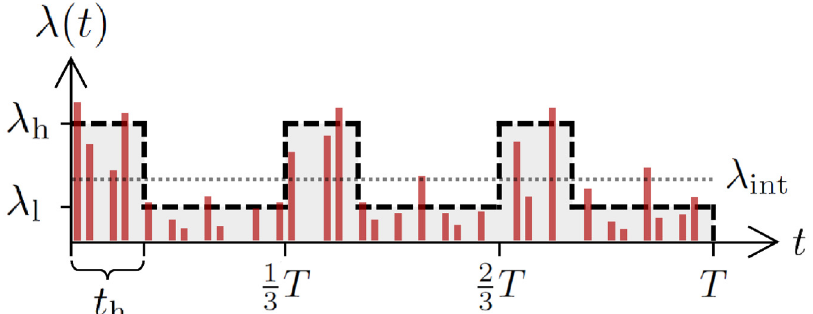
Fig 6. An illustration of the model for generating a periodic time series. The periodic time series { z ( t )} for t = 1, ... , T (red vertical lines) is generated using Eqs (5) and (6), where the time-varying parameter λ ( t ) in Eq (6) (thick dashed curve) is shaped by three parameters, i.e., λ h , λ l , and t h , in the case with n = 3. The horizontal dotted line for λ int is plotted for comparison. See the main text for details.